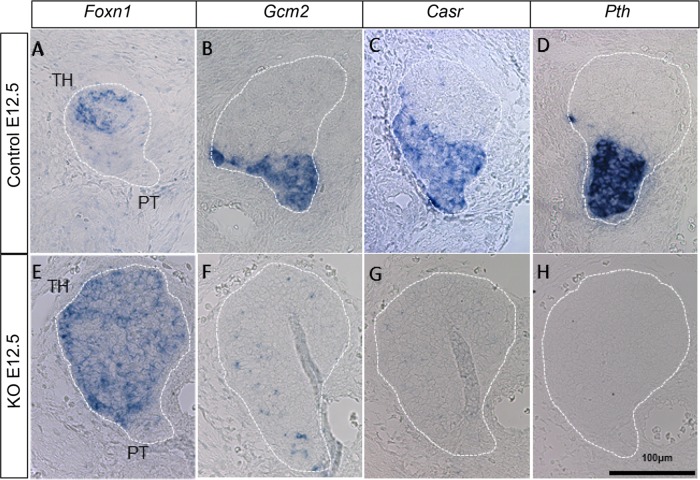
Expression patterns for marker genes in Gcm2 conditional knockout mice.In situ hybridization of parathyroid markers Gcm2 (B, F), Casr (C, G), and Pth (D, H) and thymus marker genes Foxn1 (A, E) in the primordial tissue (thymus and parathyroid) of E12.5 mice in control (A–D) and Gcm2 conditional knockout (E–H) groups. The dotted lines indicate the thymus–parathyroid primordium. The thymus (TH) and parathyroid (PT) regions are shown in A and E, respectively. Scale bars indicate 100 μm.